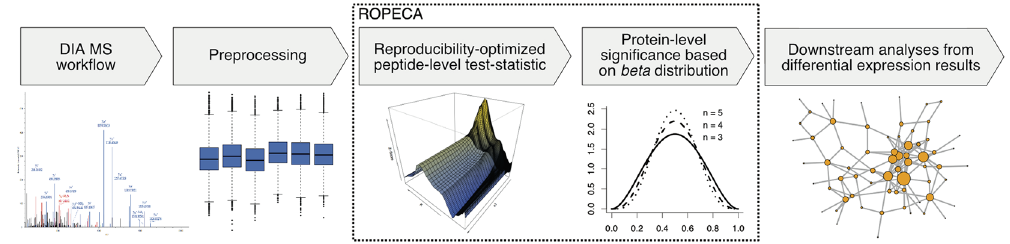
Figure 1. The general differential expression analysis workflow from experiment to downstream analysis. The dotted box highlights the ROPECA method, where the reproducibility-optimized test-statistic and the protein- level significance are calculated.